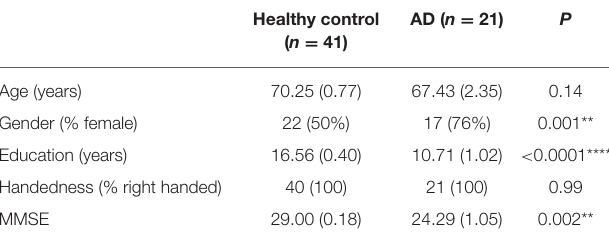
TABLE 1 | Demographic and clinical characteristics of